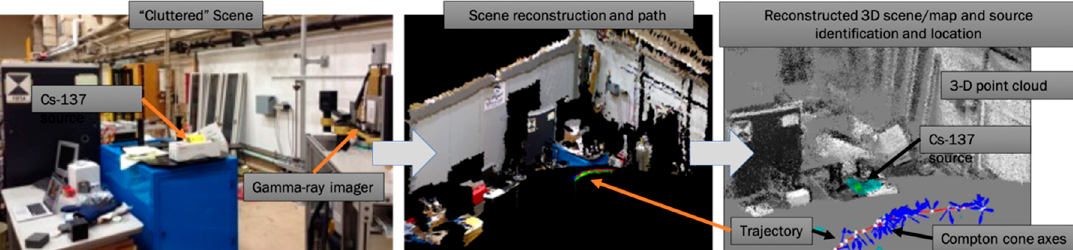
Figure 1. Steps in the creation of fused three-dimensional (3-D) scenes, from the actual cluttered scene ( left ), to the mapped 3-D scene model with the reconstructed path of the instrument ( middle ), and the 3-D scene fused with the reconstructed radiation data ( right ). For this demonstration a high-purity Ge (HPGe)-based gamma-ray imaging instrument mounted on a cart equipped with the Microsoft (MS)-Kinect was used. List-mode maximum-likelihood expectation-maximization image reconstruction was used with the reconstruction constrained to the point cloud created by the structured light sensors.